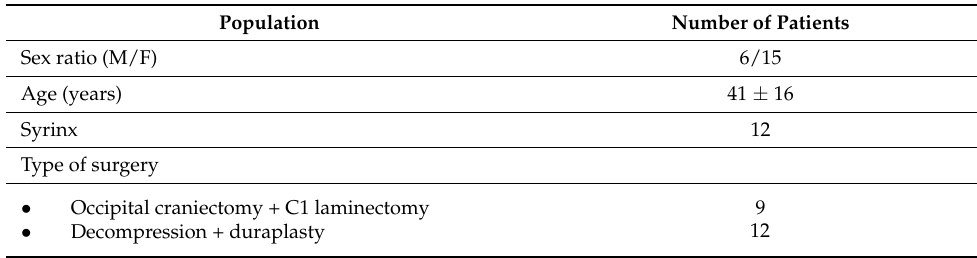
Table 1. Population characteristics.